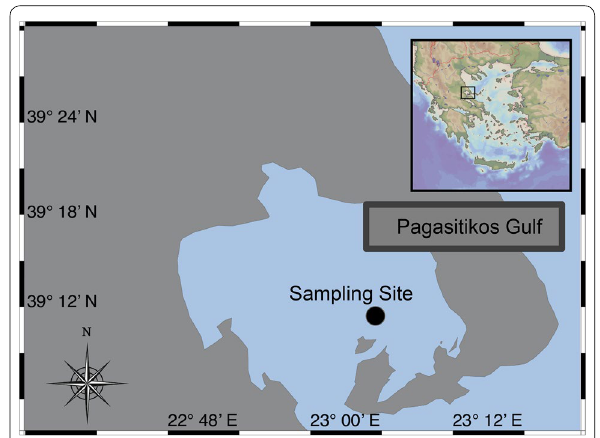
Fig. 1 Study area of Pagasitikos gulf and sampling site (black dot) of the experimental trawling (after [2])